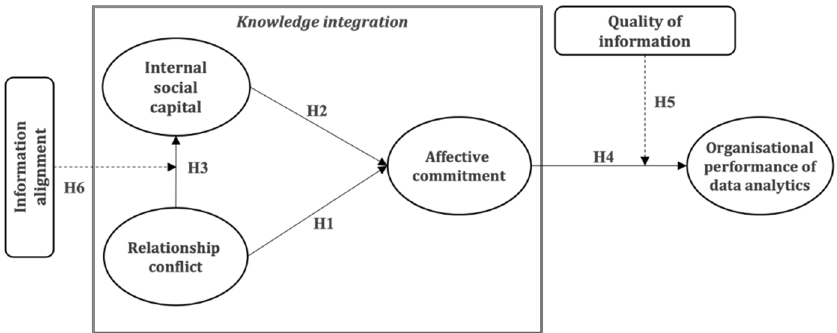
Figure 1. Conceptual model based on Chirico and Salvato [11].